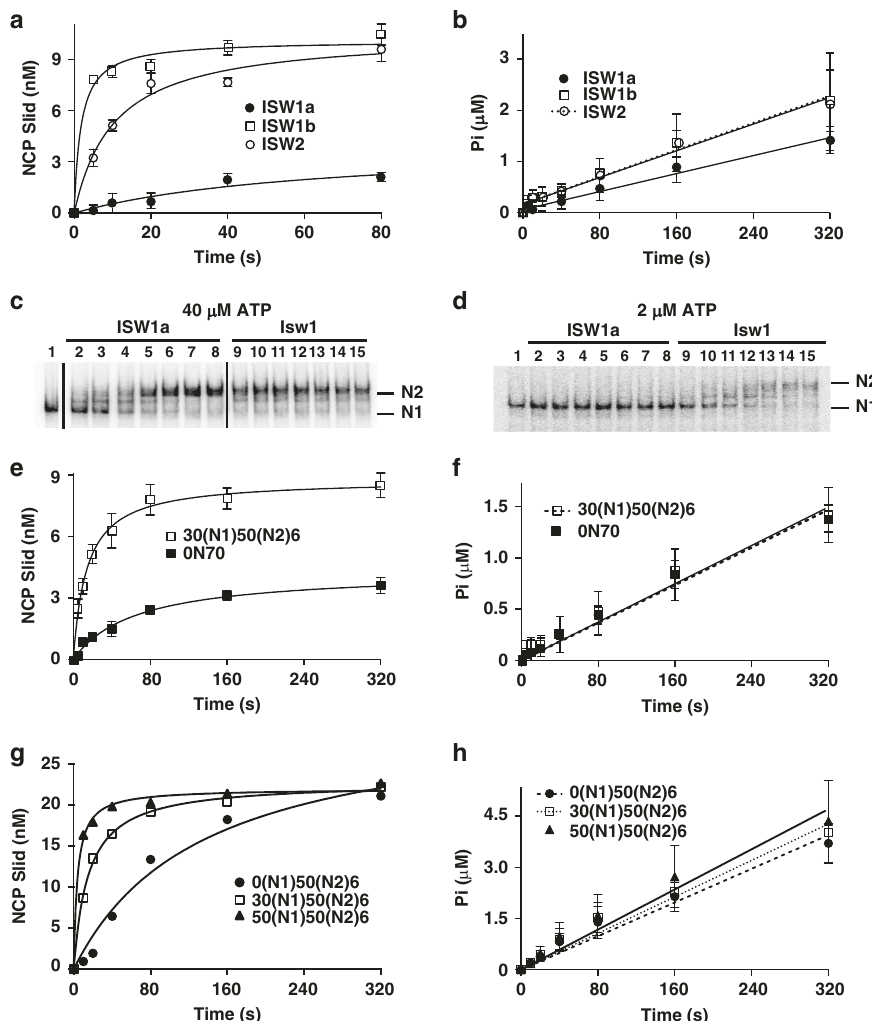
Fig. 2 ISW1a preferentially remodels dinucleosomes over mononucleosomes. a , e and g The rate ISW1a mobilizes various nucleosomal substrates was determined by EMSA for one round of remodeling with remodeler in excess to nucleosomal substrate. The ef fi ciency of ISW1a remodeling was compared to either ( a ) ISW1b and ISW2 with 0N70 mononucleosomes or ( e , g ) ISW1a with mono- and dinucleosomes. The initial rates of remodeling by ISW1a, ISW2 and ISW1b were respectively 0.060 ± 0.033, 0.77 ± 0.084 and 1.2 ± 0.12 nM s − 1 with 40 μ M ATP, 20 nM 0N70 mononucleosomes, and 80 nM ISW1a, ISW1b or ISW2. In ( e ) and ( g ) the conditions were the same, except for 16 μ M ATP in ( e ) and 2 μ M ATP and 800 μ M γ -S-ATP in ( g ). In ( e ) initial rates of 0N70 and 30(N1)50(N2)6 remodeling by ISW1a were estimated to be respectively 0.063 ± 0.018 and 0.51 ± 0.027 nM s − 1 . The initial rate of remodeling by ISW1a for 0(N1)50(N2)6, 30(N1)50(N2)6 and 50(N1)50(N2)6 in ( g ) were estimated to be respectively 0.23 ± 0.099, 1.2 ± 0.011 and 2.8 ± 0.11 nM s − 1 . b , f and h The rates of ATP hydrolysis for the remodeling conditions described above were determined using γ - 32 P-ATP and thin-layer chromatography. b The amount of inorganic phosphate (Pi) generated was plotted versus time and the observed rates of ATP hydrolysis by ISW2, ISW1a and ISW1b with 0N70 mononucleosomes were respectively 6.5 ± 0.35, 4.4 ± 0.16 and 6.6 ± 0.36 nM s − 1 . f The rates of ATP hydrolysis of ISW1a with 0N70 and 30(N1)50(N2)6 mono- and di-nucleosome were respectively 4.7 ± 0.19 and 4.6 ± 0.21 nM s − 1 . In ( h ) 40 µ M was used instead of the ATP/ γ -S- ATP mix and the rates of ATP hydrolysis for ISW1a with 0(N1)50(N2)6, 30(N1)50(N2)6 and 50(N1)50(N2)6 were respectively 12 ± 0.70, 13 ± 0.75, 15 ± 0.88 nM s − 1 . c , d The rates of ISW1a (lanes 1 – 8) and Isw1 (lanes 9 – 16) remodeling 0N70 nucleosome was determined as described in ( a ) with the ATP concentration at ( c ) 40 or ( d ) 2 µ M ATP as indicated. Reaction times were 0, 10, 20, 40, 80, 160, 320, and 640 s. Nucleosome remodeling and ATPase assays were all done in n = 3 independent experiments and error bars are presented as mean values + / − SD. Source data are provided as a Source Data fi